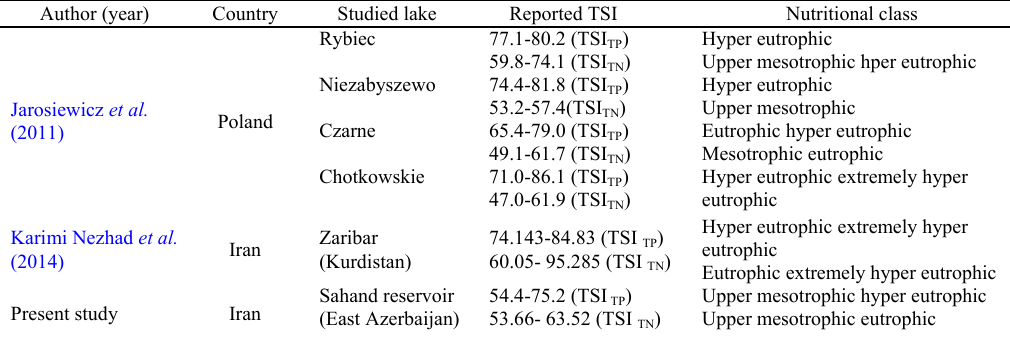
Table 3: Comparison of TSI TP and TSI TN of some selected lakes with Sahand reservoir Fig. 5: Spatial distribution of the TSI index for individual parameters and total eutrophication